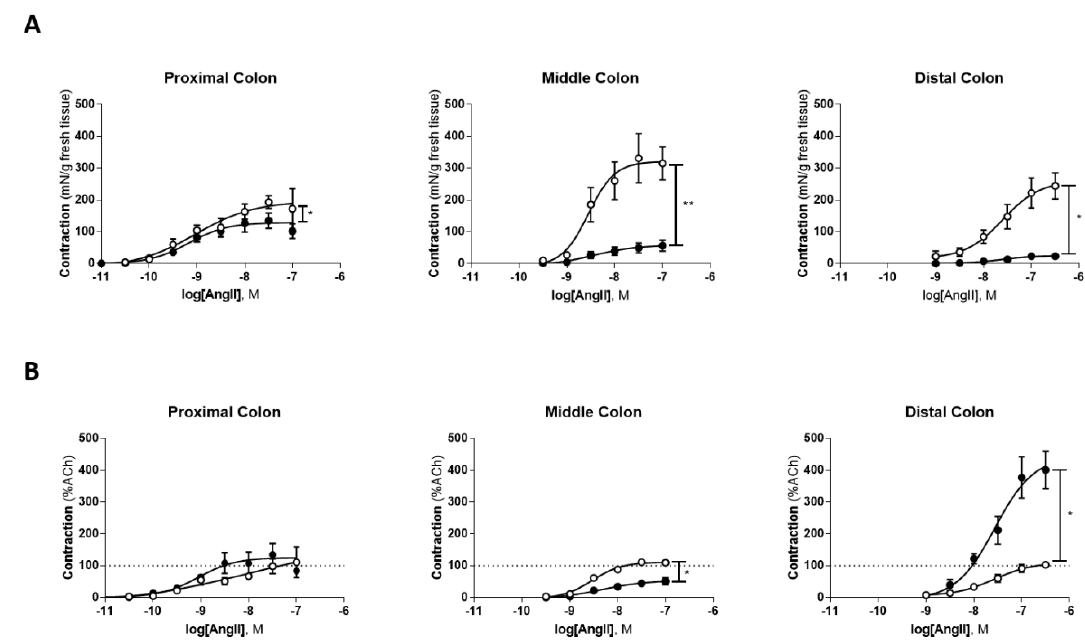
Figure 2. Concentration-response curves to Ang II. ( A ) Ang II-mediated response expressed as tension (mN/g of fresh tissue) in the proximal colon (controls, open circles, n = 7 vs. TNBS-induced rats, black circles, n = 10), middle colon (controls, open circles, n = 5 vs. TNBS-induced rats, black circles, n = 10) and distal colon (controls, open circles, n = 6 vs. TNBS-induced rats, black circles, n = 6); ( B ) Ang II-mediated response expressed as a percentage of ACh (%ACh) in the proximal colon (controls, open circles, n = 7 vs. TNBS-induced rats, black circles, n = 9), middle colon (controls, open circles, n = 5 vs. TNBS-induced rats, black circles, n = 10) and distal colon (controls, open circles, n = 6 vs. TNBS-induced rats, black circles, n = 6). Vertical lines point to statistically significant differences in the E max of the corresponding groups, * p < 0.05, ** p < 0.0001.